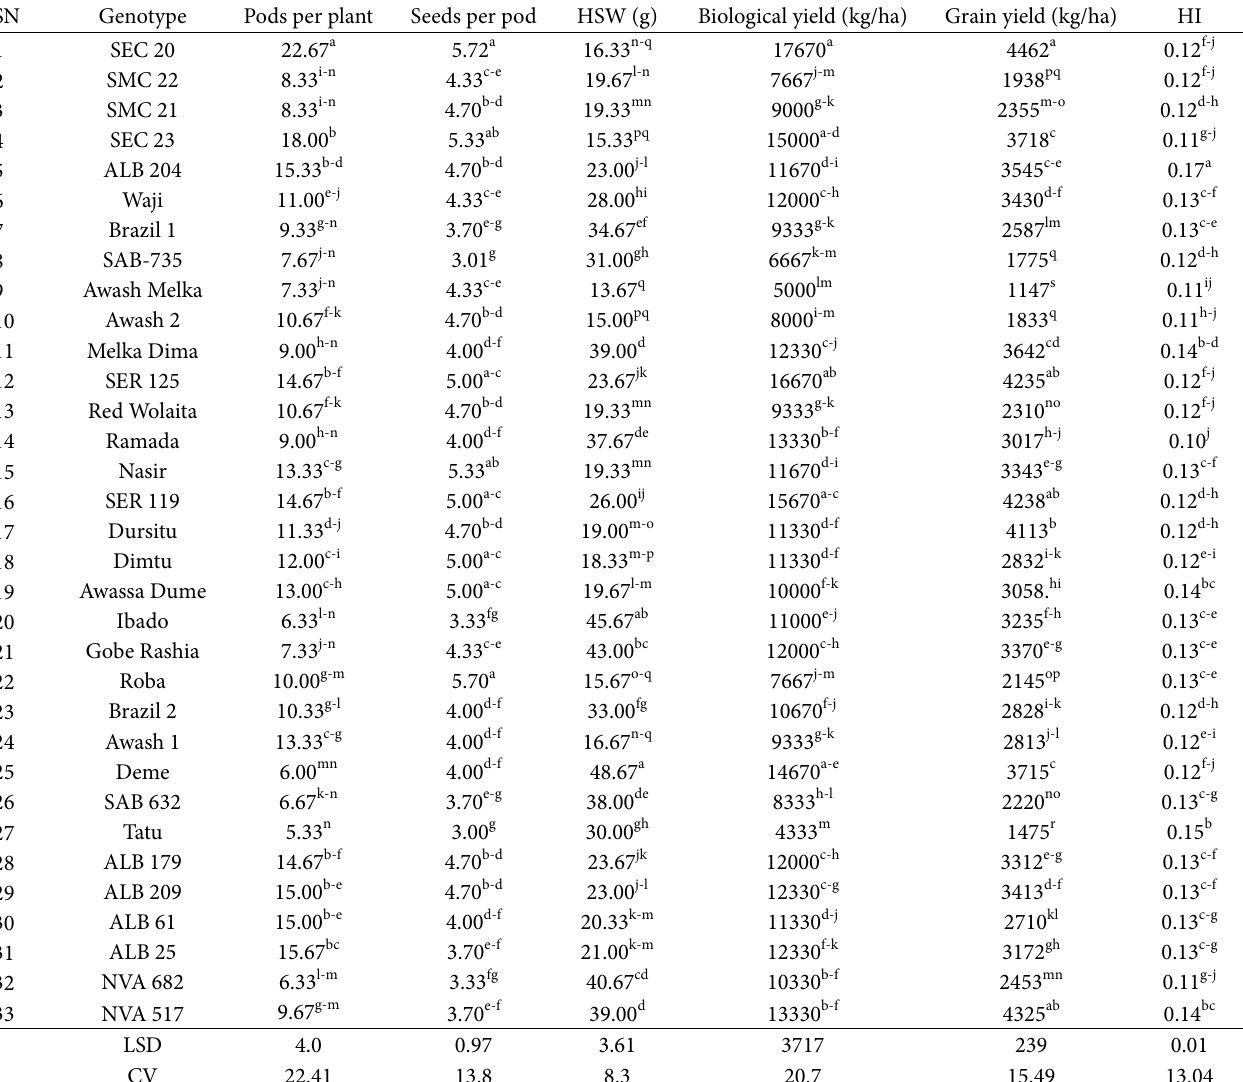
Table 2: Mean performance of genotypes of common bean for yield and yield